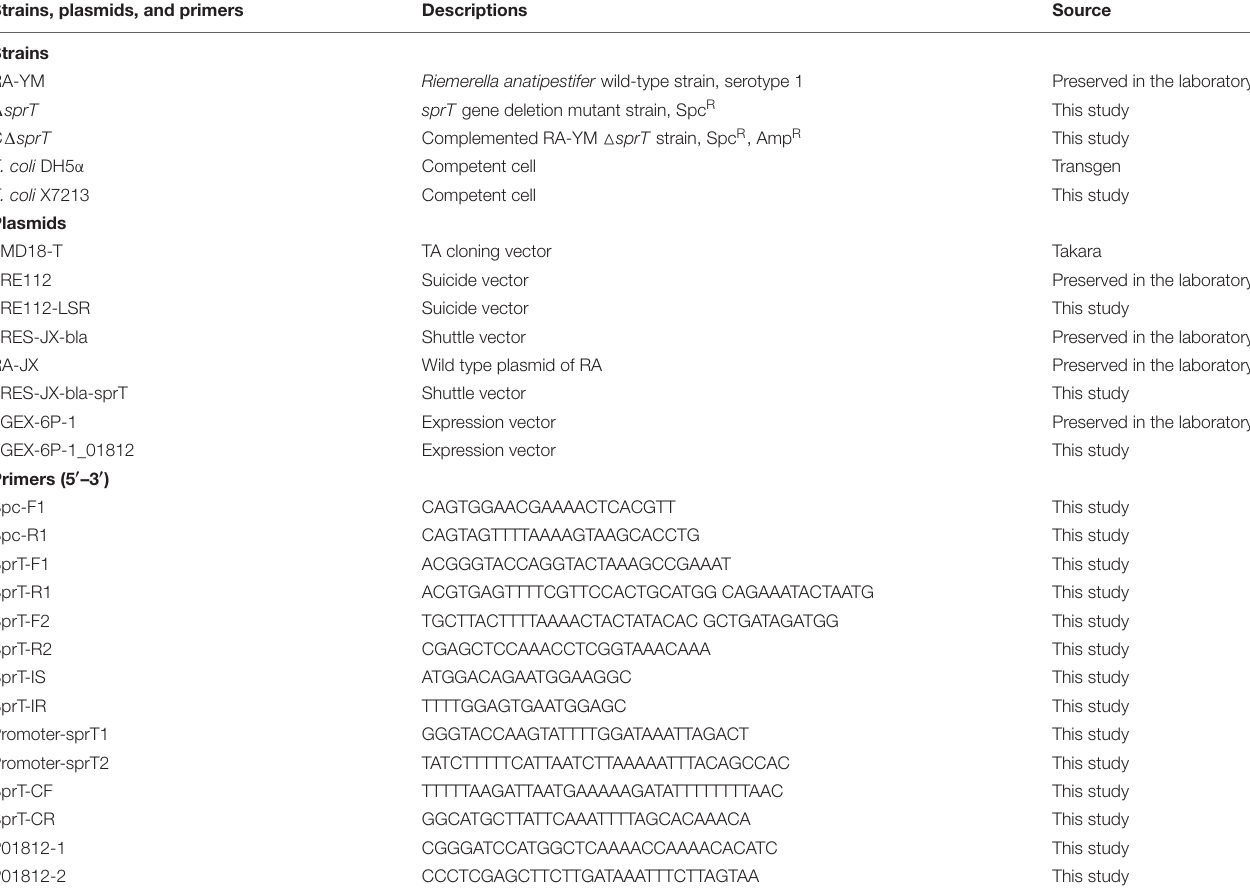
TABLE 1 | Strains, plasmids, and primers used in this study. Strains, plasmids, and